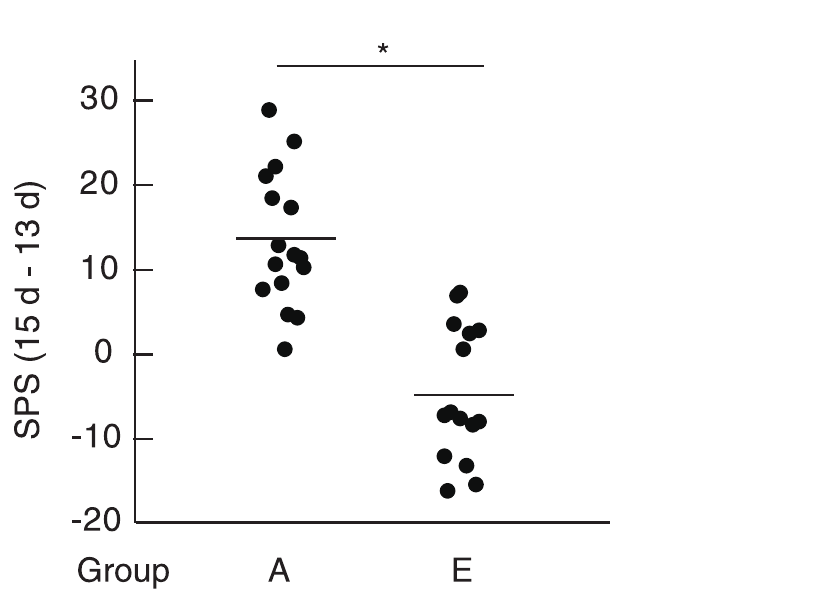
Fig 6. Effects of PAR2 antagonist (FSLLRY-NH 2 ) on the pain-related behaviors. Calculation of single paw standing of mice belonging to group A and E were performed according to the methods described under Materials and methods. Data from four experiments were combined. Total number of mice used were 15 and 14 for group A and group E, respectively. Each dot represents difference of single paw standing ( Δ SPS) between day 15 and day 13 of a single mouse. Averages were shown by bars. � p < 0.0001.